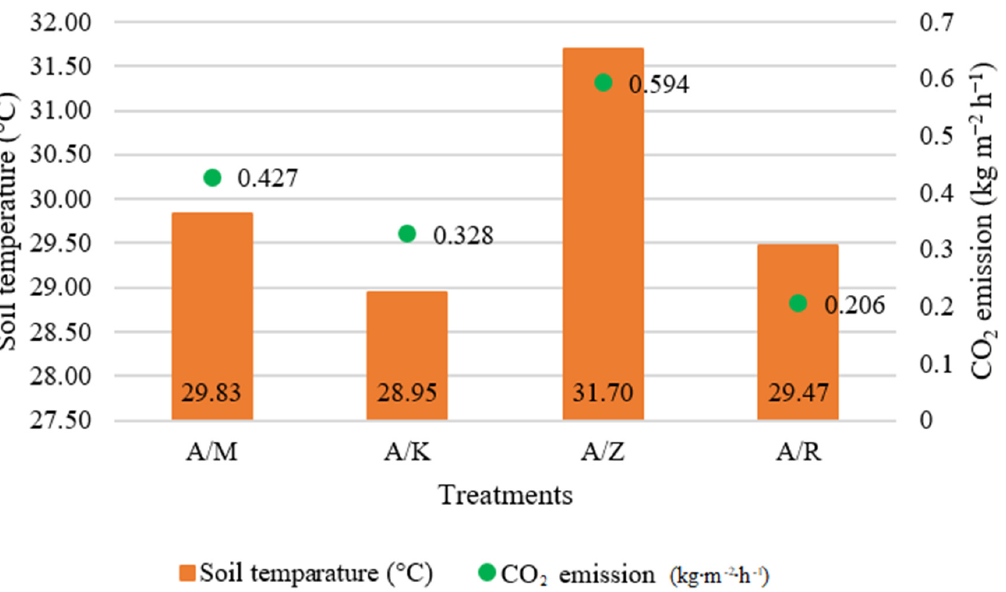
Figure 5. Average results of soil temperature ( ◦ C), CO 2 -emission (kg m − 2 · h − 1 ) by treatment on 11 September 2019 (Karcag). Note: A/Z: Unused/abandonment grassland treatment; A/M: mulch treatment; A/K: Mowing treatment; A/R: